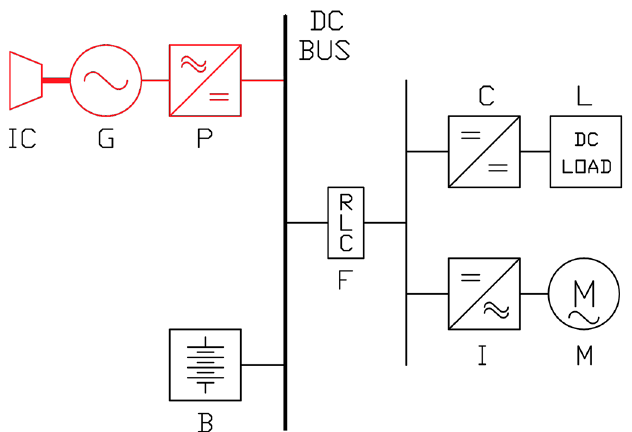
Figure 1. Proposed direct current (DC) microgrid; the power system section in battery-only operation is shown in black.